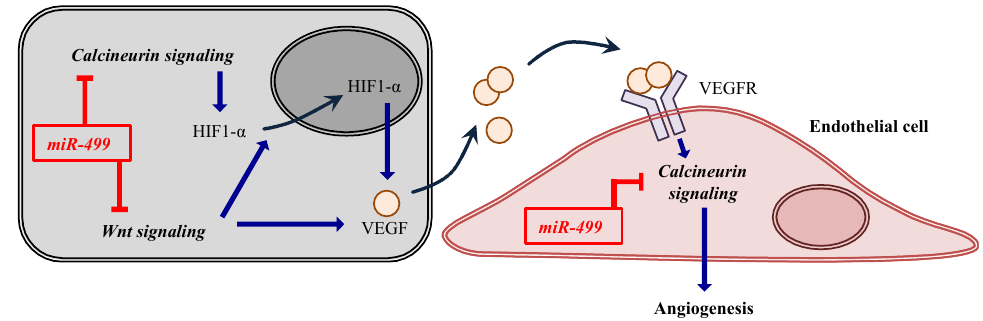
Scheme 1. Associations of signaling pathways and miR ‐ 499. The blue arrows indicate upregulation. The red symbols mean inhibition.